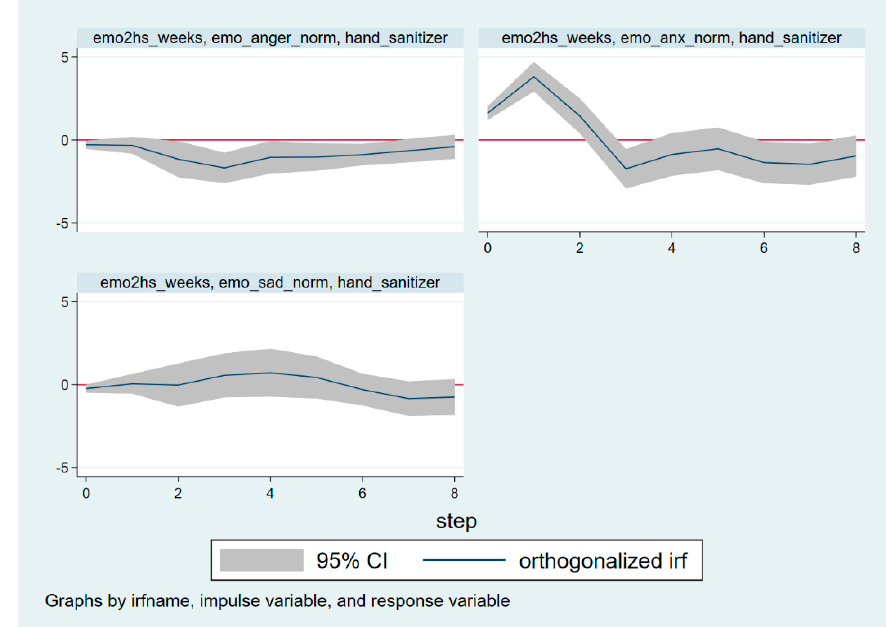
Figure 4. The impact of one standard deviation shock on preventive